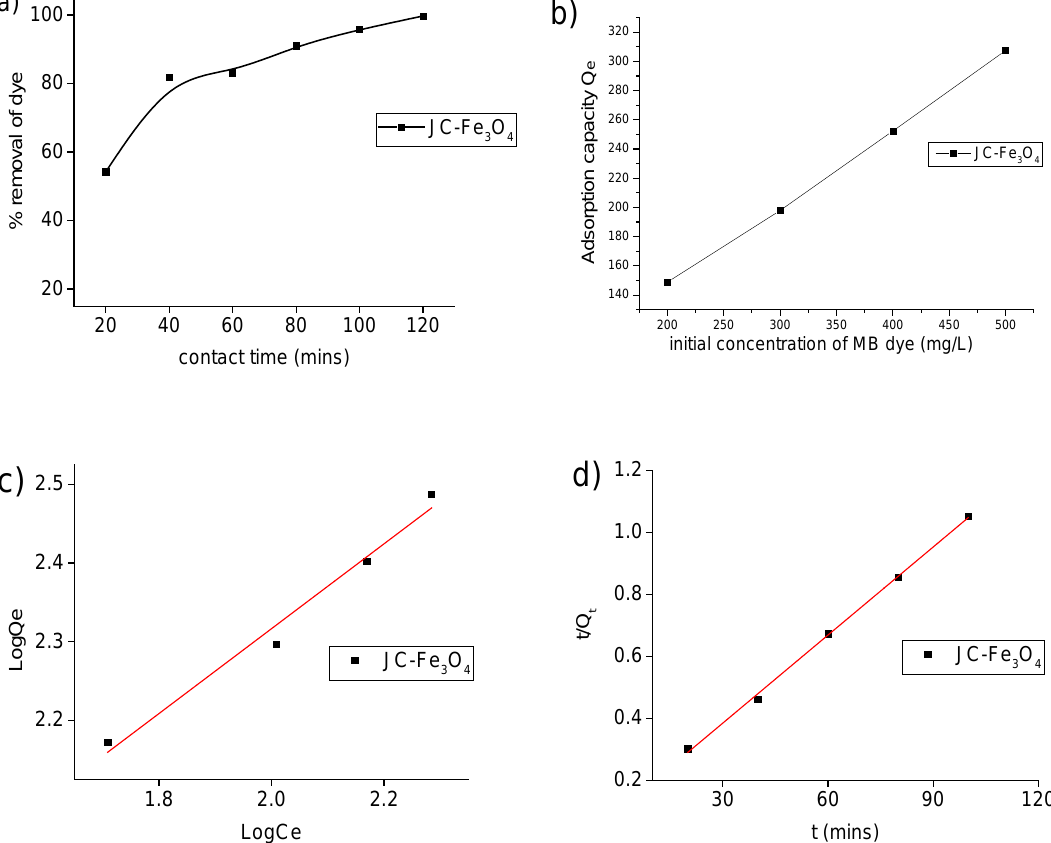
Figure 6. Plot of ( a ) % removal of MB dye with contact time; ( b ) adsorption capacity ( Qe ) of MB dye with concentration; ( c ) Freundlich adsorption isotherm model (Log Q e vs Log C e ); ( d ) Pseudo-second-order kinetic model for adsorption t / Q t vs. t (mins) of JC-Fe 3 O 4 NPs.